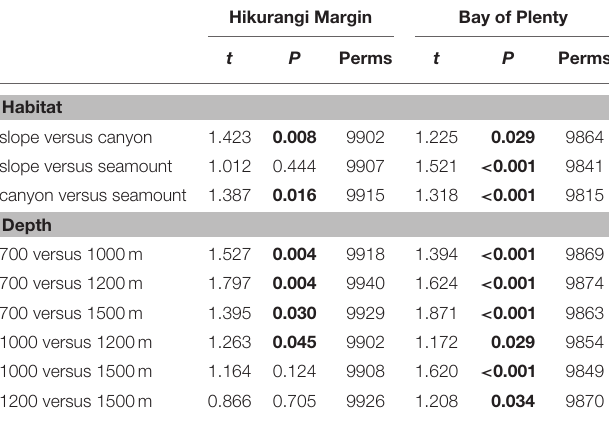
TABLE 2 | Results of pairwise PERMANOVA analyses testing for the effects Habitat (slope, canyon, and seamount) and Depth (700, 1000, 1200, and 1500m) on megafauna community structure in Hikurangi Margin and Bay of Plenty after accounting for the effect of spatial covariates (latitude, longitude; results not